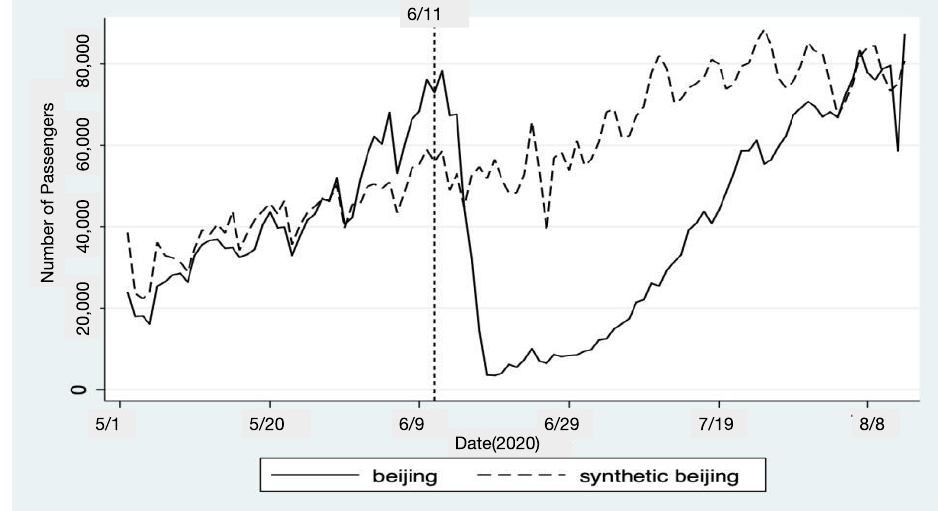
Figure 5. Beijing air passenger changing trend (SCM).